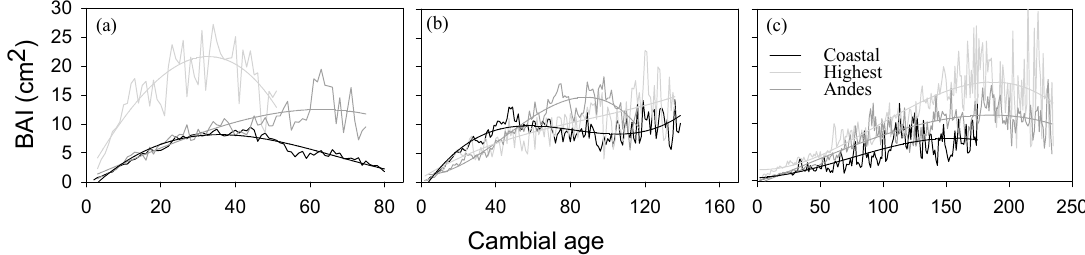
Figure 2. Basal area increment (BAI; cm 2 year − 1 ) of the three cluster populations according to cambial age. ( a ) < 80 years, ( b ) 81–160 years, and ( c ) > 161 years.